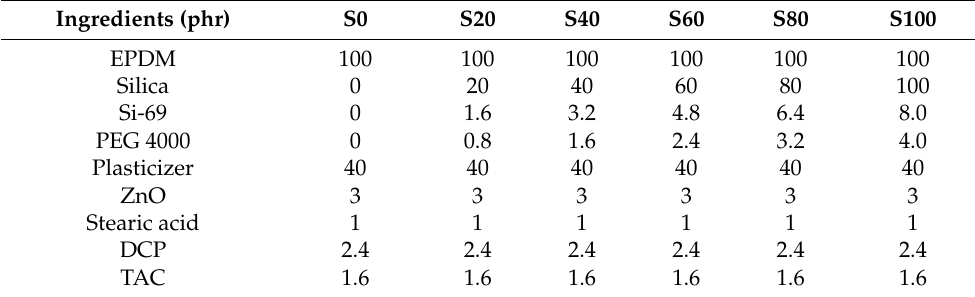
Table 1. Formulation of EPDM/silica composites with different silica